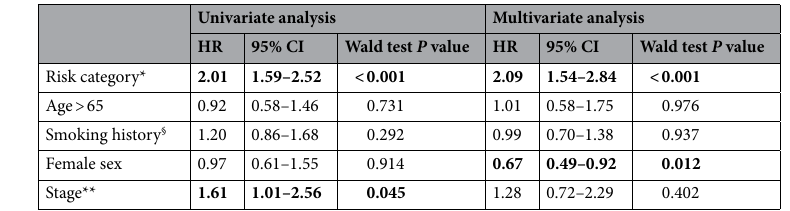
Table 1. Cox proportional hazards models for 5-year freedom from recurrence. Univariate and multivariate cox proportional hazards modeling of the association between recurrence, recurrence risk category, and clinicopathologic factors is shown. Significant values are in bold. *Compared to low risk category. § < 5, 6–20, 21–40, > 40 pack-years. **Stage IA v.